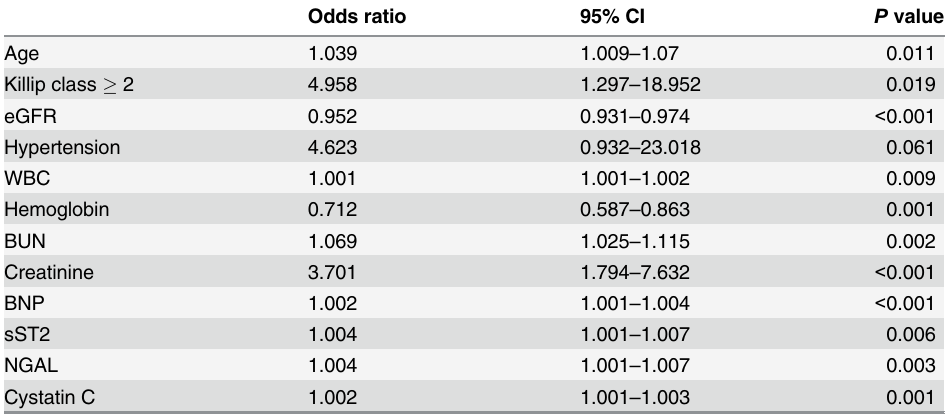
Table 2. Univariate analysis of predicators of acute kidney injury within 48 hours.